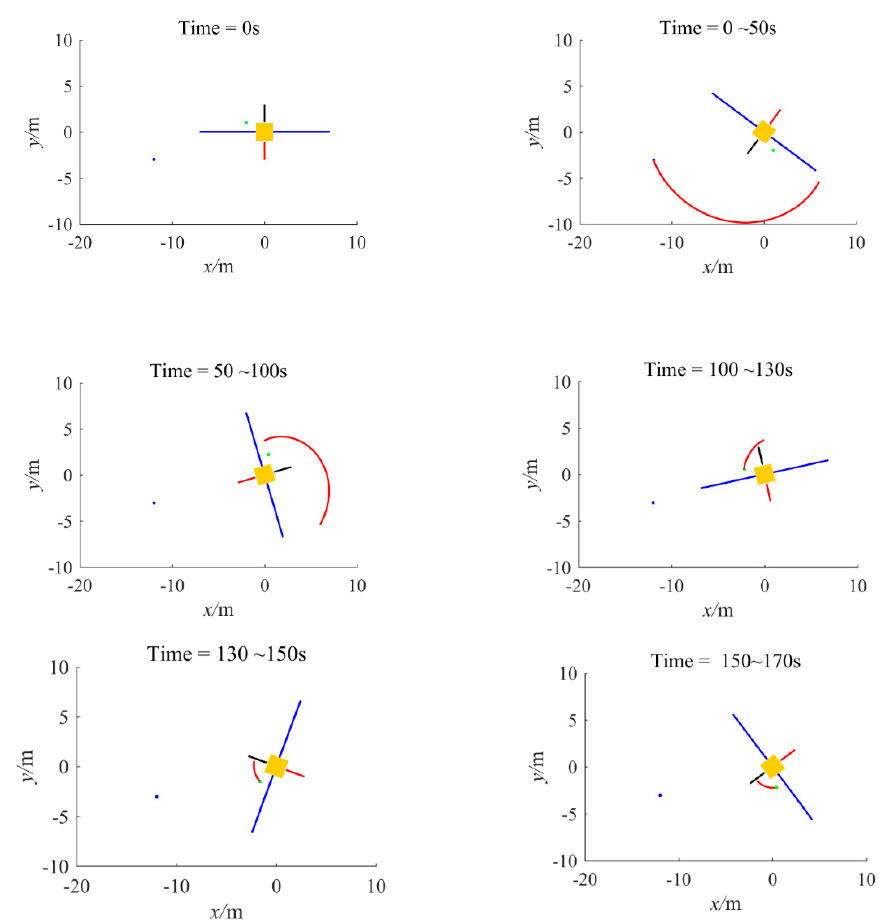
Figure 12. The servicer’s trajectory and the target’s attitude change.